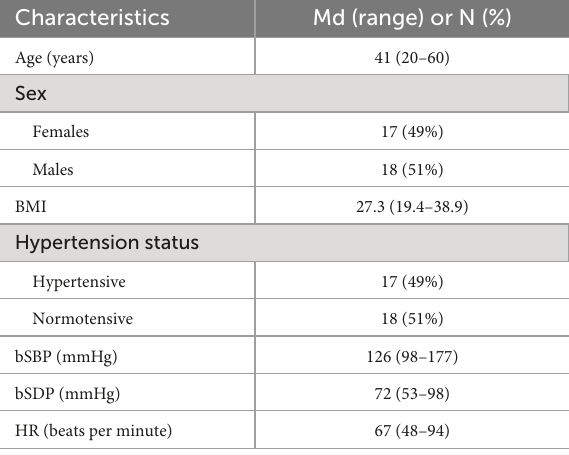
TABLE 1 Characteristics of participants, N = 35.